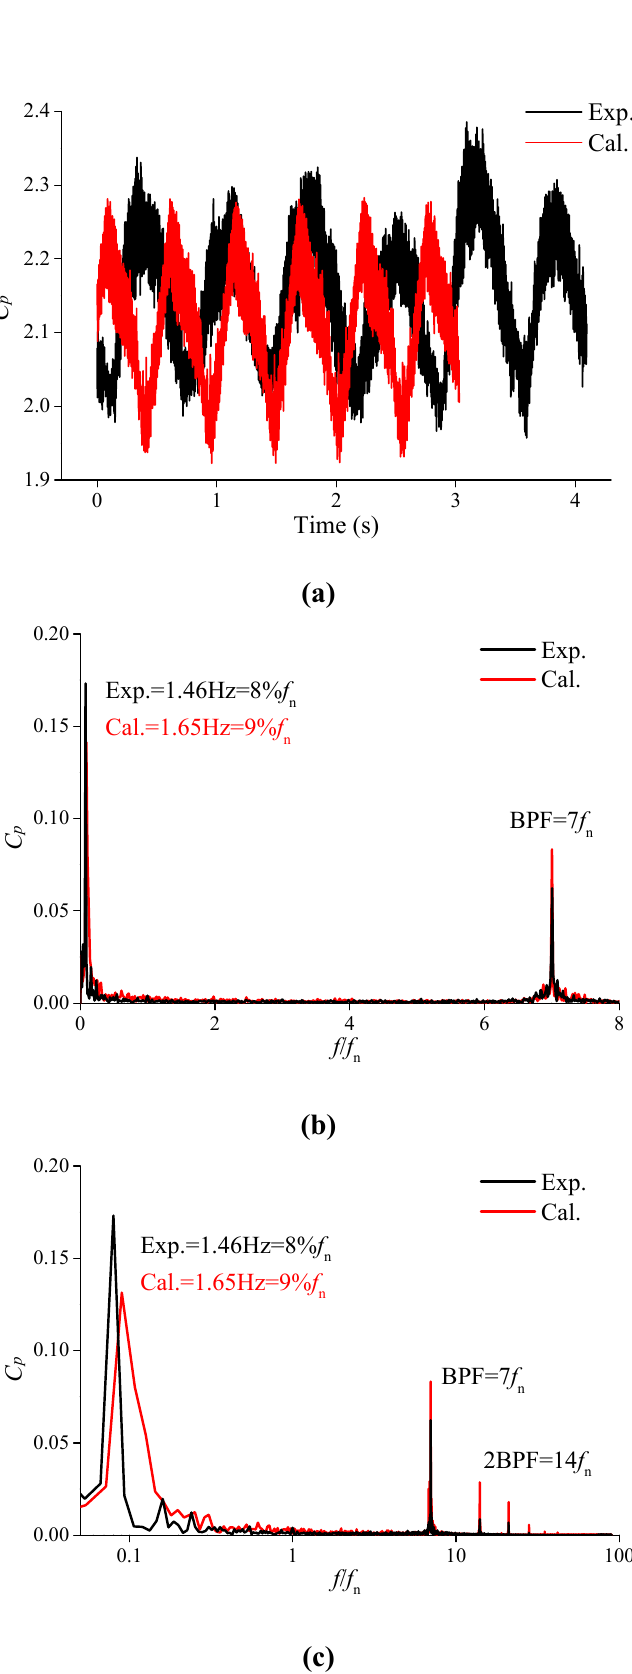
Figure 9. Pressure signals at vaneless space (gv1) at condition II. (a) Pressure fluctuations, and FFT results with (b) linear and (c) logarithmic abscissa.